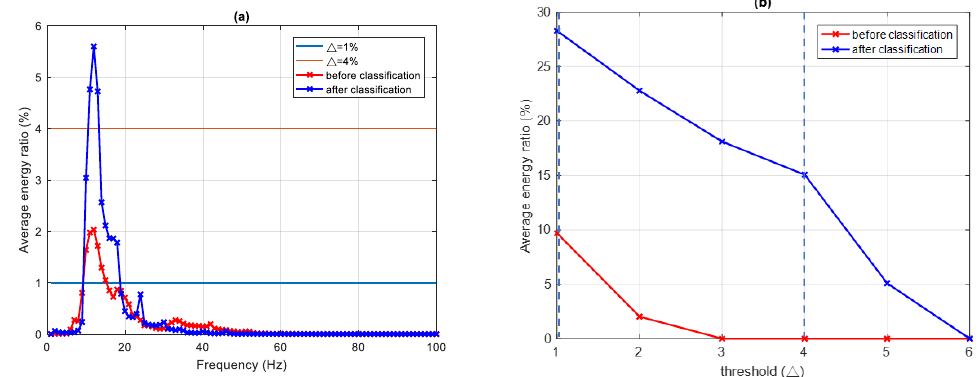
Figure 10. MF2 of class II, ( a ) average frequency–energy distribution comparison of before and after classification with ∆ = 1%, and ∆ = 4%, and ( b ) threshold and average energy ratio distribution with before and after classification.